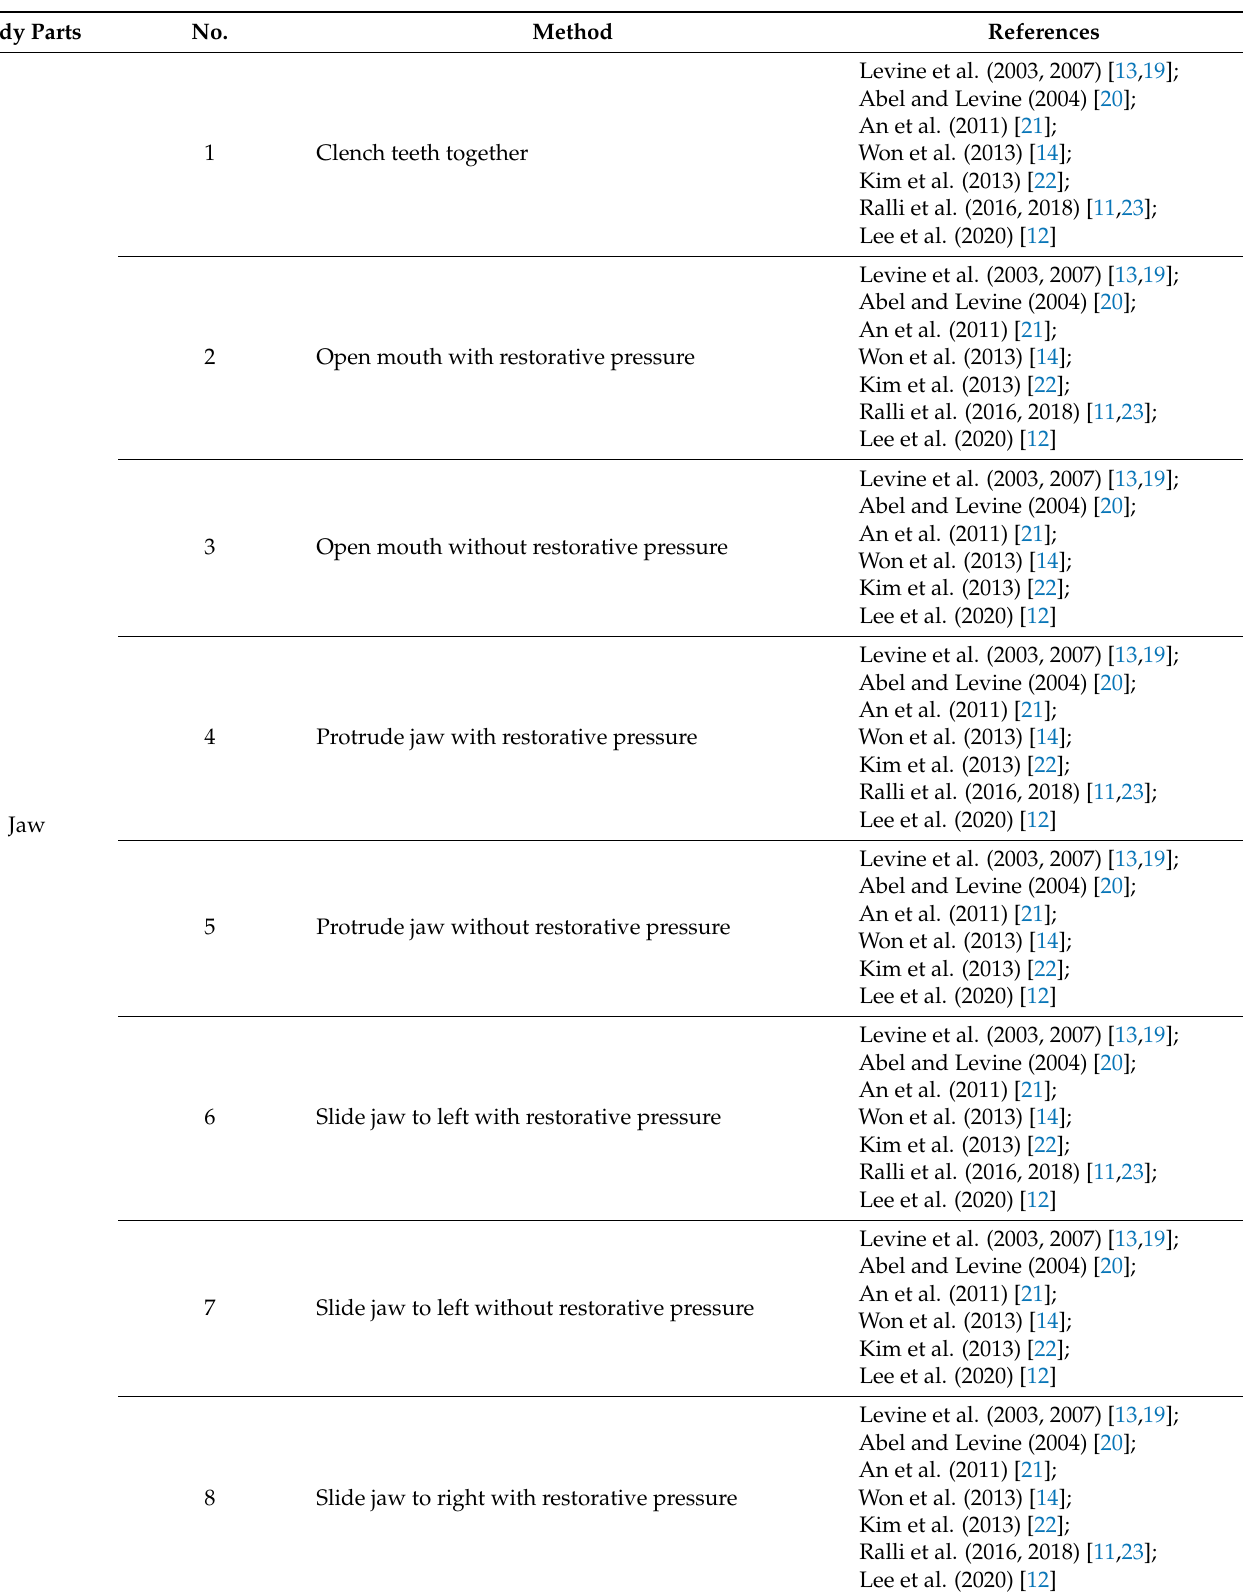
Table 1. Somatic maneuver methods for each body